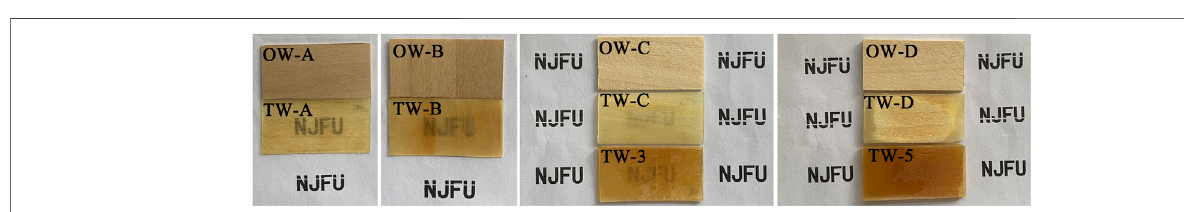
FIGURE 9 | Transmittance before and after treatment.